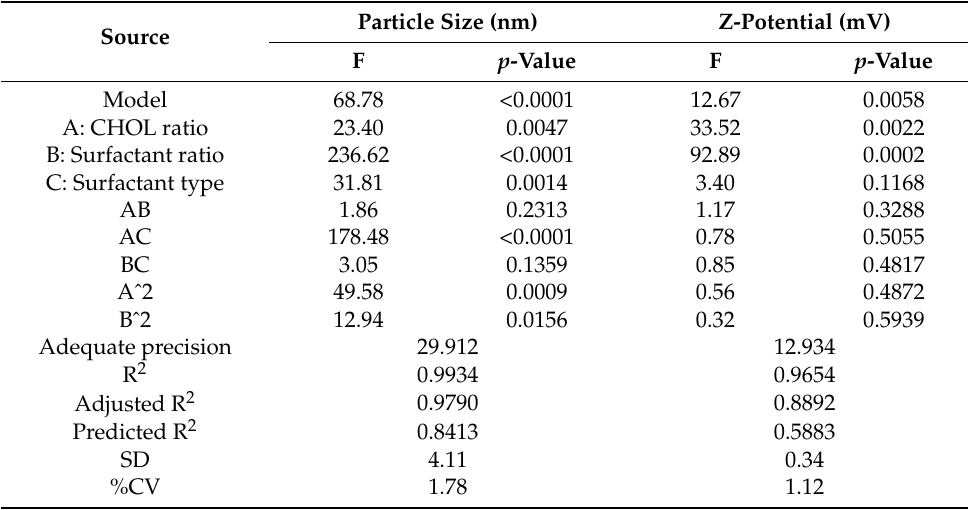
Table 2. The design expert results of all response